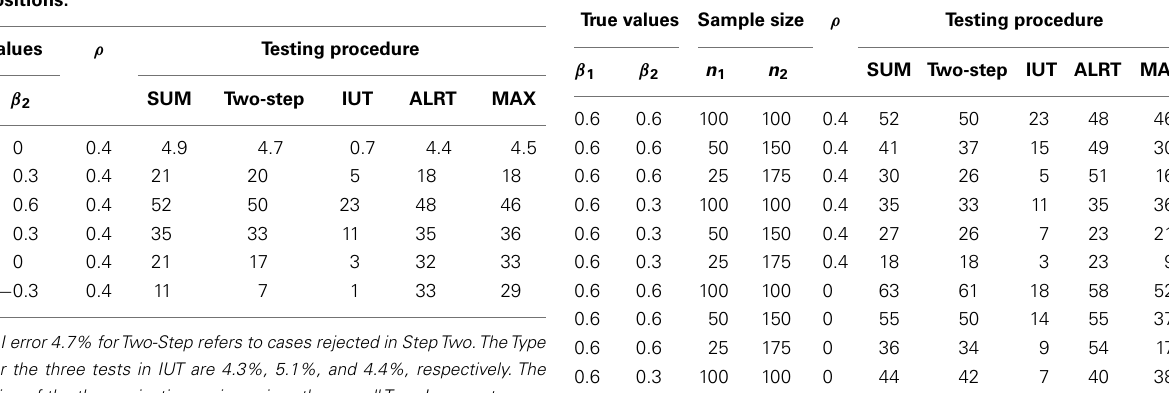
Table 5 | Simulation results: power (%) with different sample